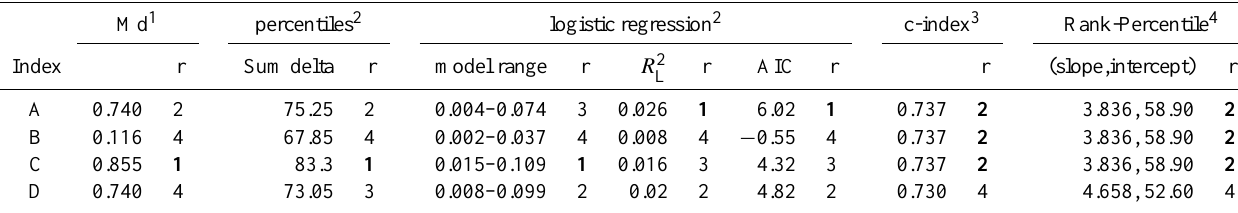
Table 1. Comparator values and ranks for each index applied to the 4 hypothetical indices. Md = Mahalanobis distance; R 2 as per Andrews et al. (2003); AIC = Akaike’s Information Criteria, r = rank. Bold numbers in the rank column indicate the “best” index